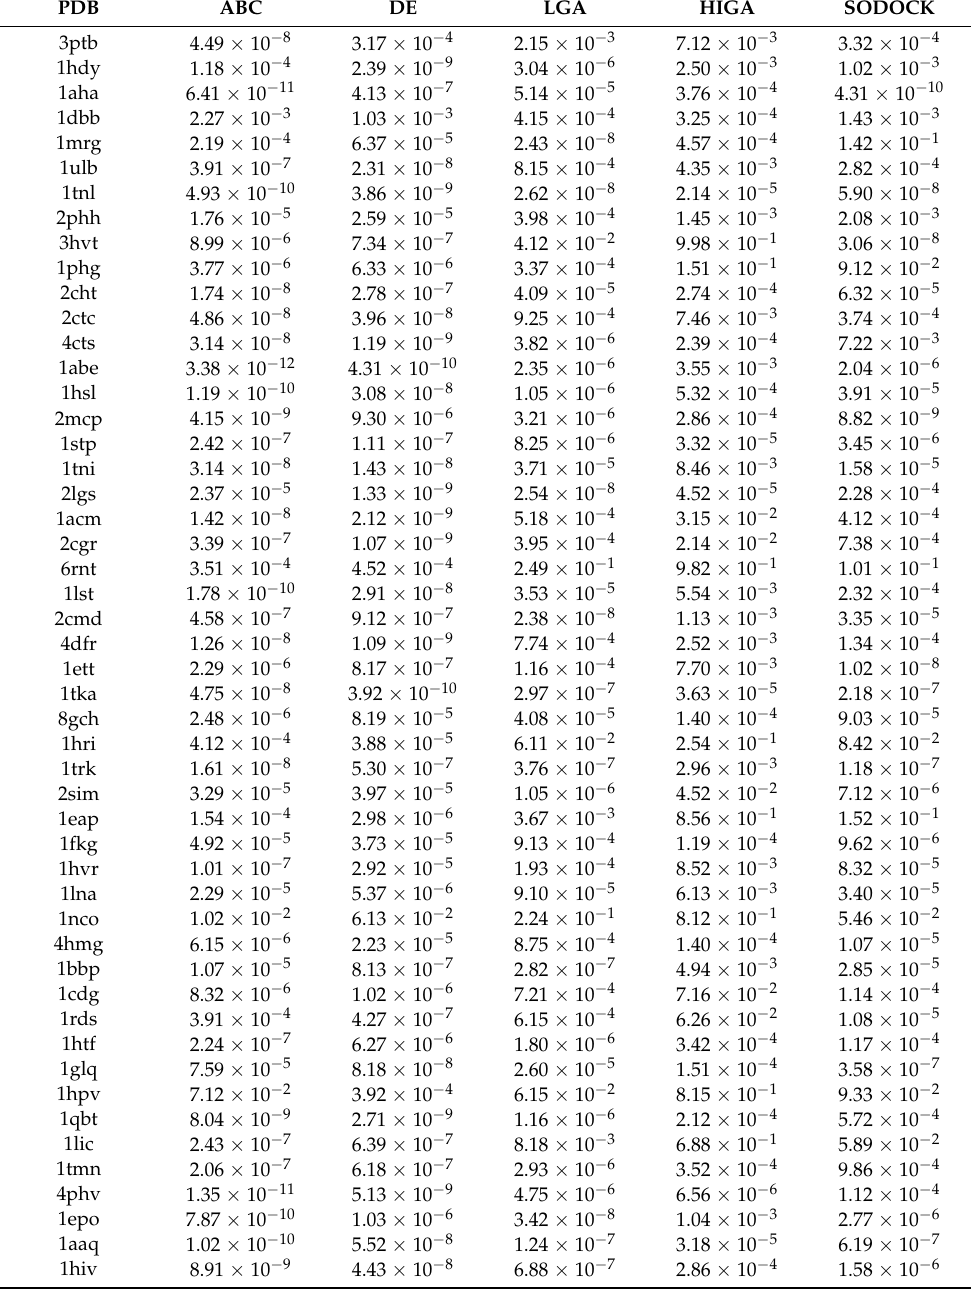
Table 4. The lowest energy and the smallest RMSD of the best predicted